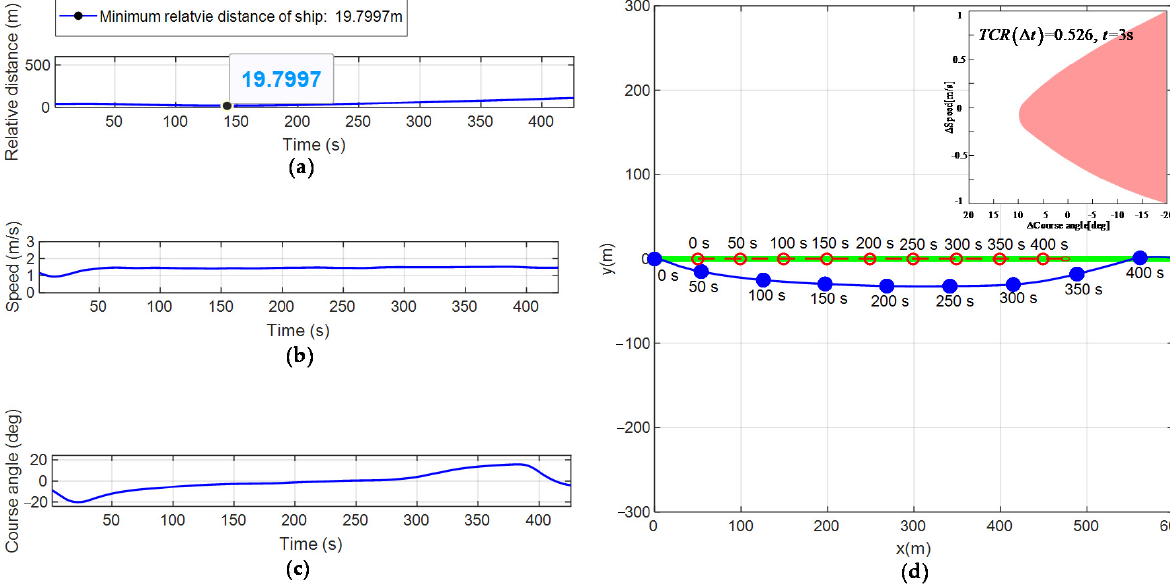
Figure 12. Obstacle avoidance process in the over-take encounter scenario. ( a ) Relative distance; ( b ) Change of velocity; ( c ) Change of yaw angle; ( d ) Obstacle avoidance process.